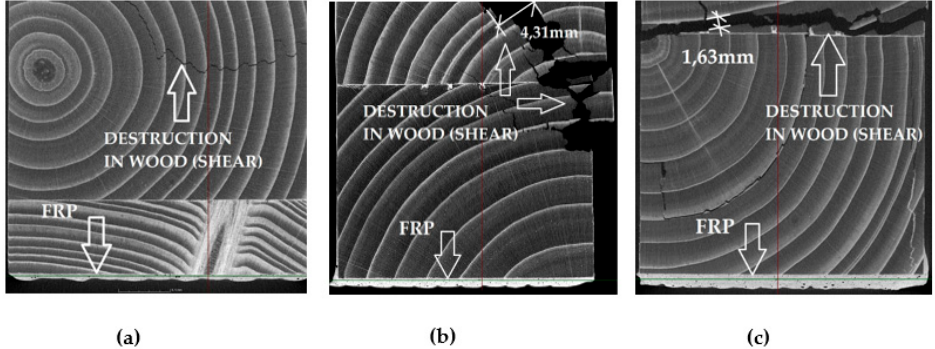
Figure 13. Cross-sections in the middle of the span for selected beams—state after the destruction: ( a ) Beam No. 1/4, ( b ) Beam No. 3/4, ( c ) Beam No. 5/2.